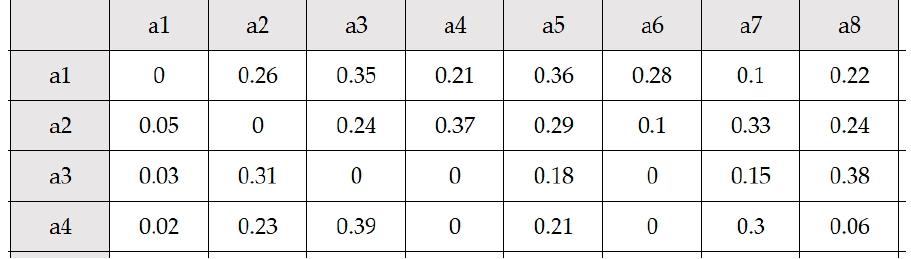
Figure 3. The influence matrix. a 1 –a 8 indicates intrusion actions. The IF value of a 1 on a 2 is 0.26.